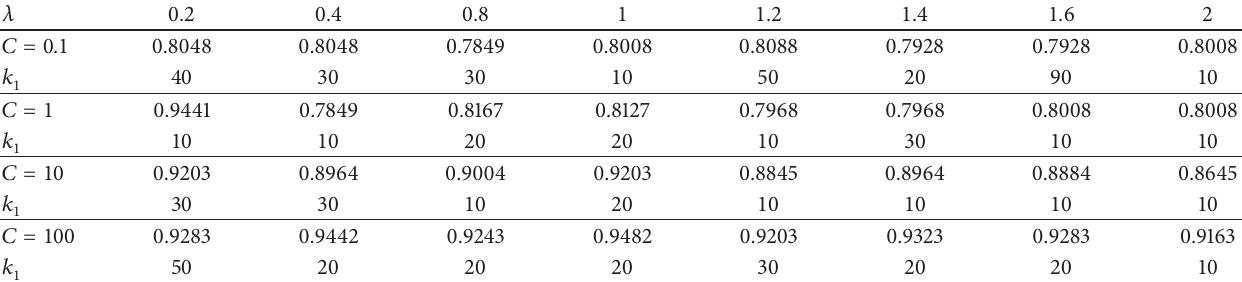
Table 2: The effects of trade-off parameter 𝜆 on classification performance; let 𝜎 1 = 𝜎 2 = 2 .